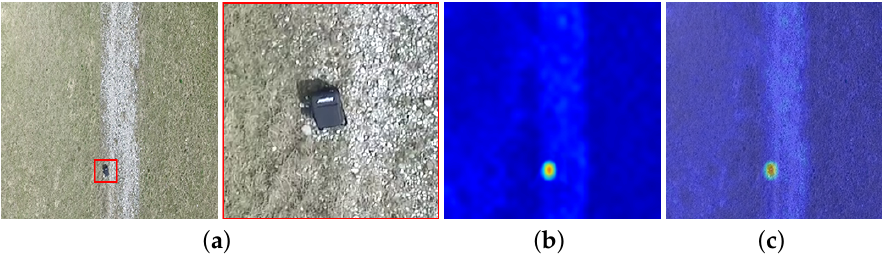
Figure 4. Example of heat map generation in an abnormal frame during the test phase. In ( a ), the frame depicting an abnormal item (i.e., the abandoned backpack); in ( b ) the heat map M produced by localizer model; in ( c ) the resulting